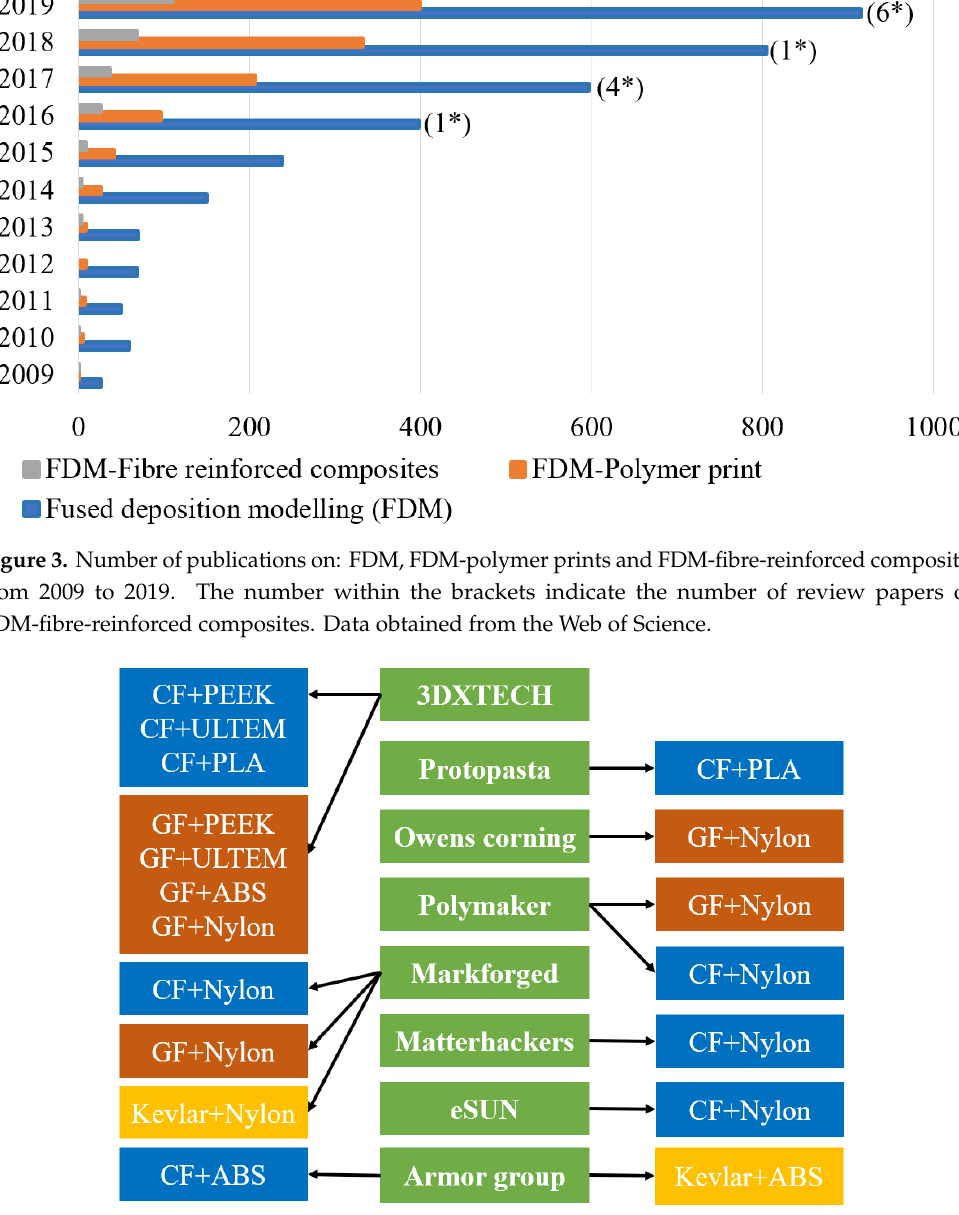
Figure 4. FDM filament and printer manufacturers (middle column) and their associated fibre-reinforced composite products. Key fibres reinforcements include carbon fibre (CF), glass fibre (GF) and Kevlar (KF), while popular matrix are polyether ether ketone (PEEK), Acrylonitrile butadiene styrene (ABS), Polylactic Acid (PLA) and Nylon.